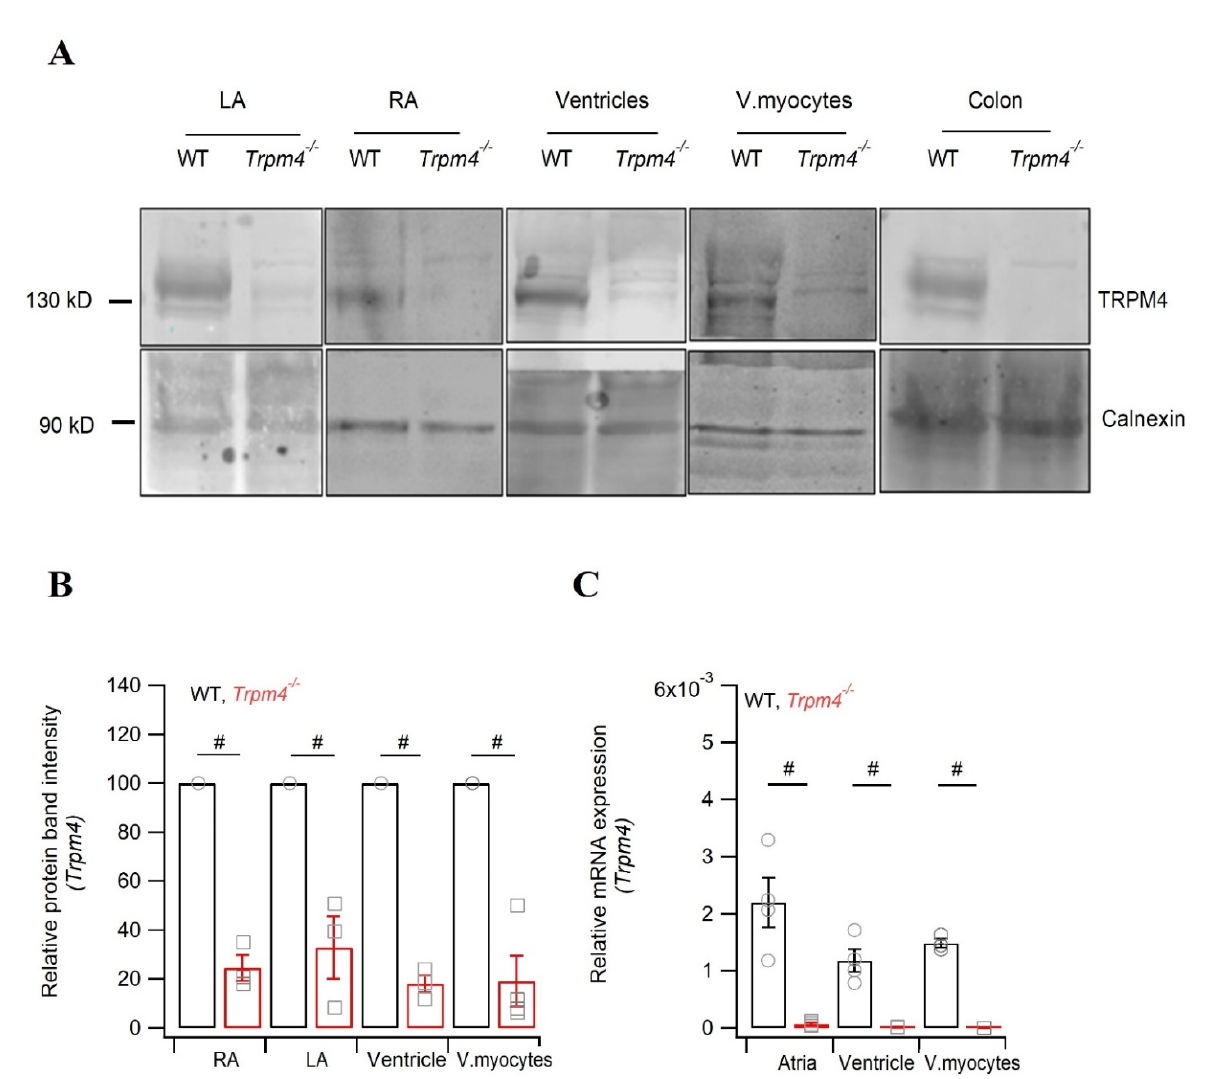
Figure 1. Expression of Trpm4 in mouse heart models. ( A ) Representative immunoblots of Trpm4 protein expression from right (RA) and left (LA) atrium, ventricles, isolated ventricular myocytes (v.myocytes), and colon tissue. ( B ) Quantification of the immunoblot showing protein expression in the atria (N = 10), ventricles (N = 11), and v.myocytes ( N = 4). ( C ) Quantification of Trpm4 mRNA using RT-qPCR. The Ct values were normalized to GAPDH ( N = 4). Note: #: p < 0.05, WT (circle, black) vs. Trpm4 −/− (square, red). Table 1. Action potential parameters in atrial and ventricular myocytes from WT or Trpm4 -/- animals.